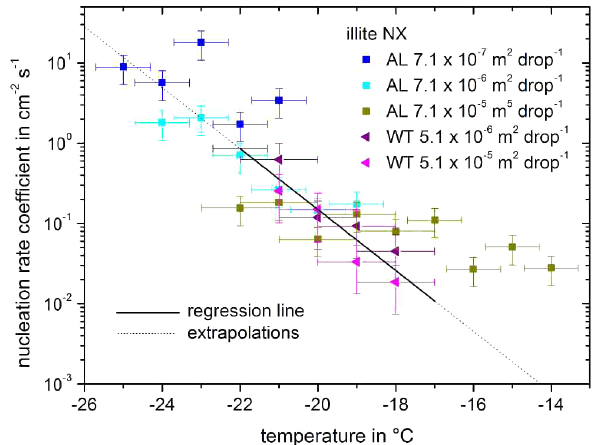
Figure 7. Nucleation rate coefficients as functions of temperature for illite NX for various particle surface areas per drop, determined by two experimental